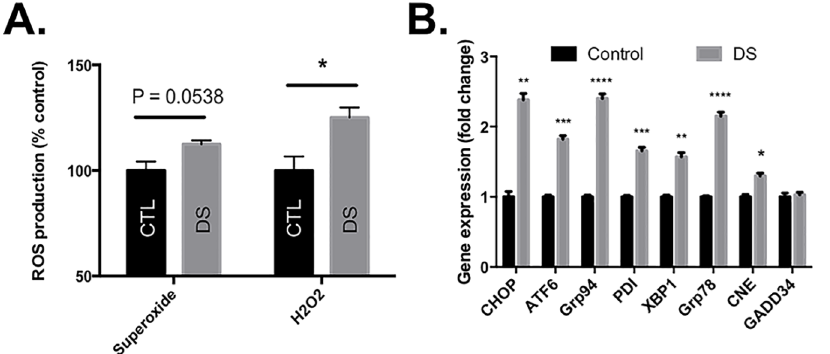
Fig 2. LCLs from DS patients enhanced basal levels of ROS production (A) and expression of ER stressgenes (B). UnstimulatedDS and CTL LCLs were evaluatedfor basal superoxide and hydrogen peroxide productionusing flow cytometry. These unstimulated cells were also assessedfor ER stress gene expressionusing qRT-PCR. N = 3; * P < 0.05; ** P < 0.01; *** P < 0.001; **** P < 0.0001.